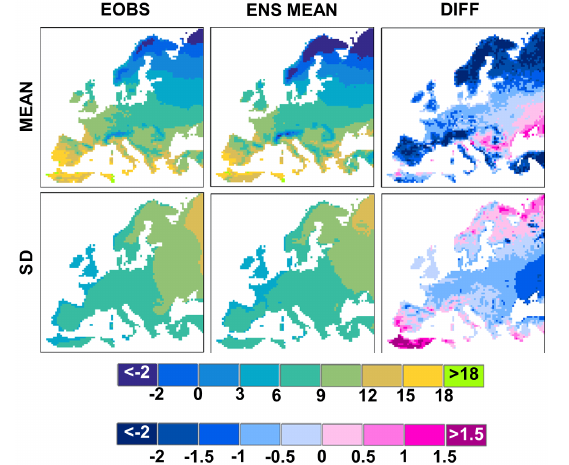
Figure 3. Mean temperature (upper) and standard deviation (lower) for EOBS, RCM ensemble (ENS) and for their difference (model – obs) (DIFF) for the reference period 1951–2005.